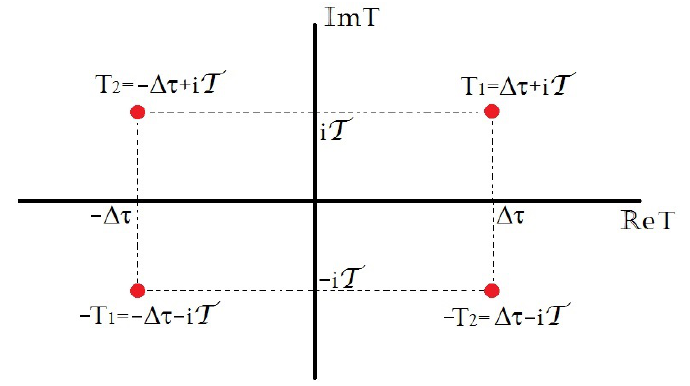
Figure 10. Pole structure of the regulator product (cid:24) T ( (cid:28) ) (cid:24) T ( (cid:28) 0 ) in the complex plane of T = (cid:28) + (cid:28) 0 . depending on the phase in z = j z j e i(cid:18) , this regulator can be divergent. In order to